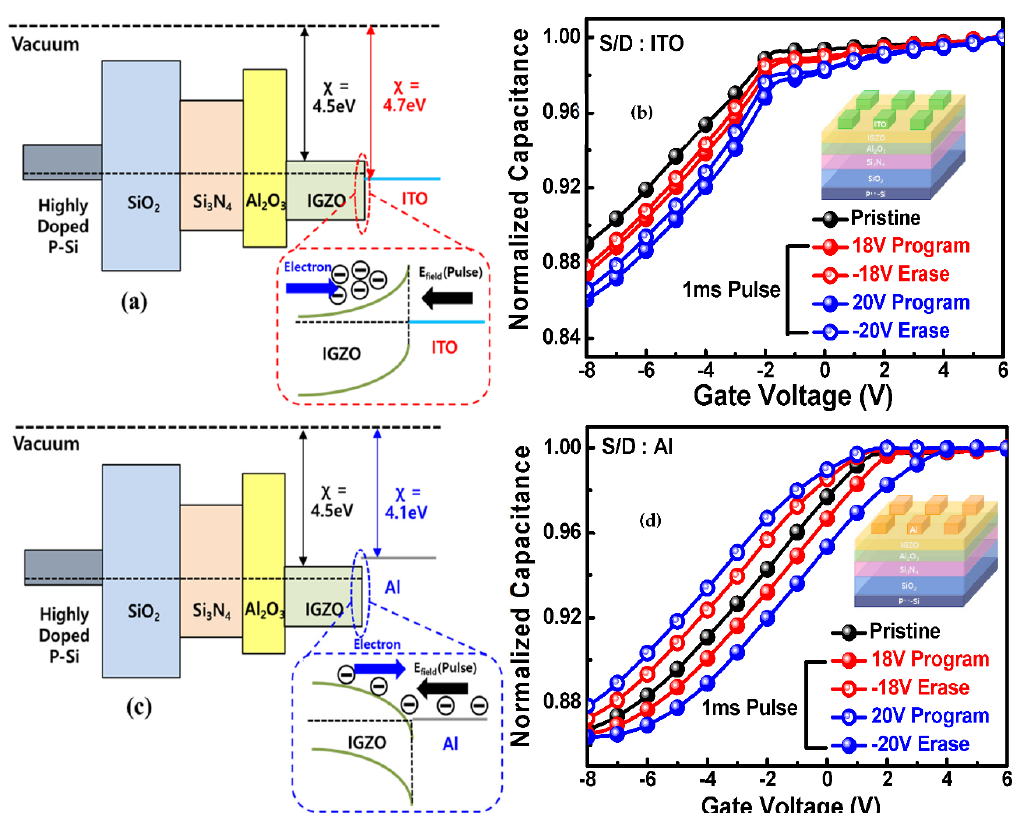
Figure 6. Memory performance of devices using amorphous and crystallized IGZO active layers with different pulse conditions: ( a ) a-IGZO and ( b ) CAAC-IGZO. ( c ) V th shift for different TNLs and program pulses.